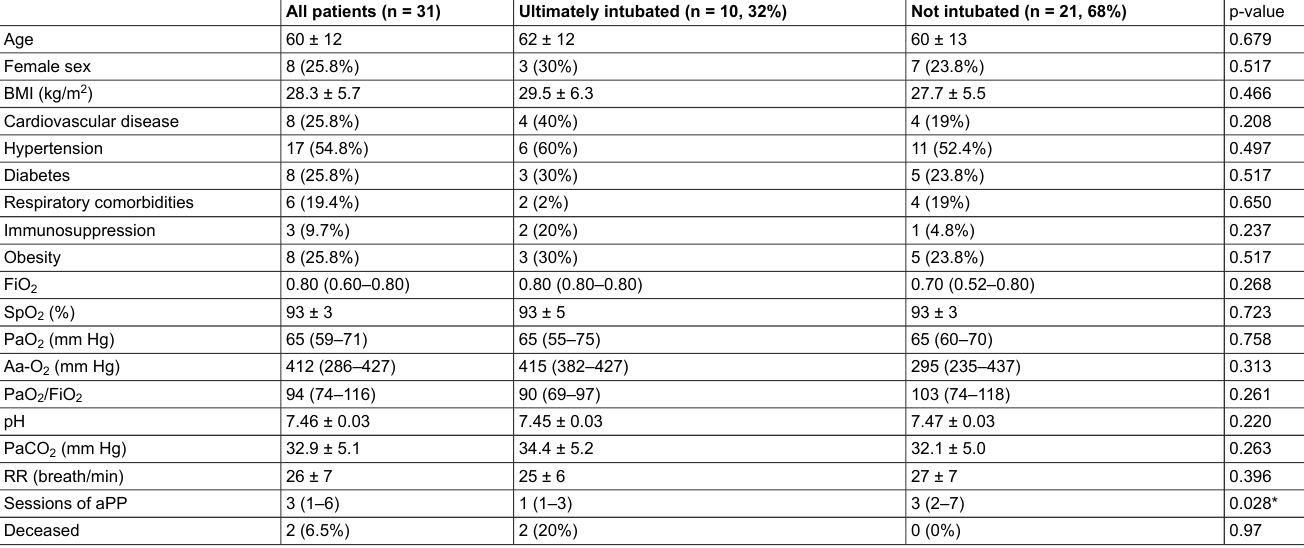
Table 1: Characteristics at admission for all patients and for the two groups intubated and non-intubated. All patients (n = 31)